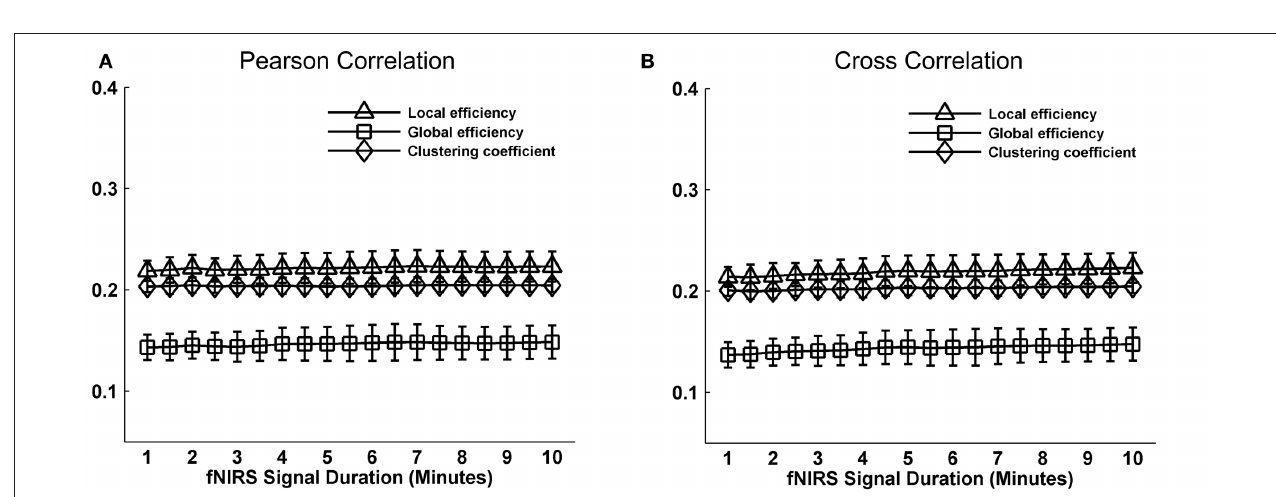
FIGURE 4 | Effect of fNIRS signal acquisition duration on the stability of local efficiency, global efficiency, and clustering coefficient. (A,B) Graphs show the magnitude SD ) of local efficiency, global efficiency, and clustering coefficient plotted by duration of fNIRS signal acquisition (1.0 (mean ± metrics and clustering coefficient in (A) and (B) calculated from Pearson correlation-derived and cross-correlation-derived networks, respectively. Statistical analysis using paired t -test indicates no significant differences in the magnitude of a graph metric associated with a given fNIRS signal acquisition duration compared with the magnitude of the same graph metric when computed by using 10 min of fNIRS data. These data constitute nearly horizontal lines, with little difference between the magnitudes of the computed graph metrics at each data collection